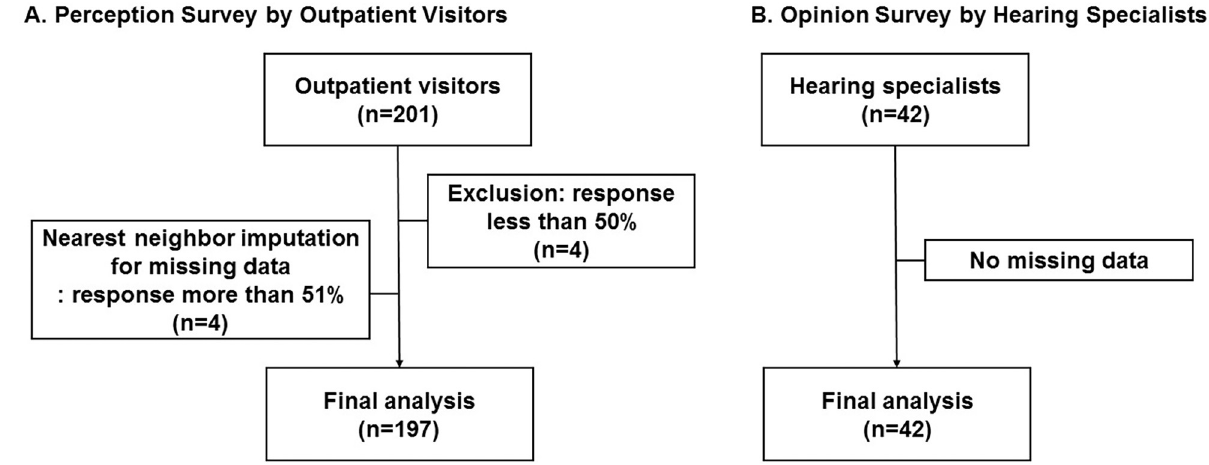
Fig 1. A flow chart of the methods. (A) Perception survey was conducted on 201 outpatient visitors. Outpatient visitors who responded less than 50% (n = 4) were excluded. 4 outpatient visitors responded more than 51% but did not finish the survey, and the missing data of these outpatient visitors was handled with nearest neighbor imputation method. Total of 197 outpatient visitors were included and analyzed for the perception survey. (B) Opinion survey was conducted on 42 hearing specialists, and there was no missing data.